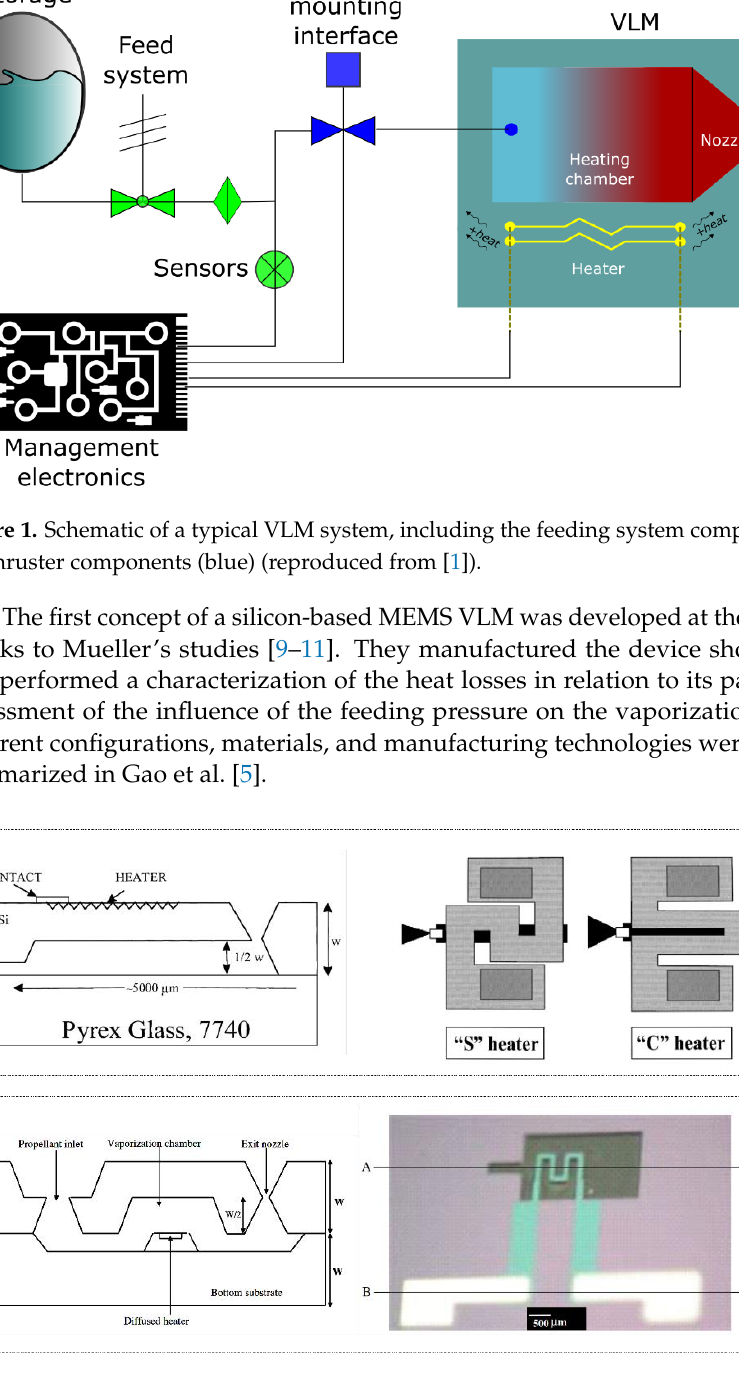
Figure 2. Manufactured VLMs in single channel configuration: ( a ) Mukerjee et al. [12]; ( b ) Maurya et al. [13].